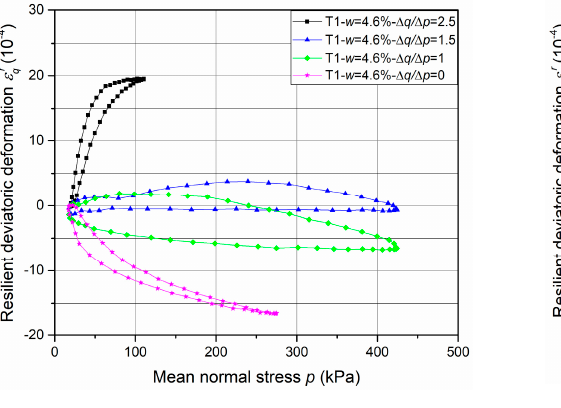
Figure 13. Resilient volumetric deformation ε vr with different fixing methods: ( a ) T1- w = 4.6%-screw; ( b ) T8- w = 4.6%-tube.